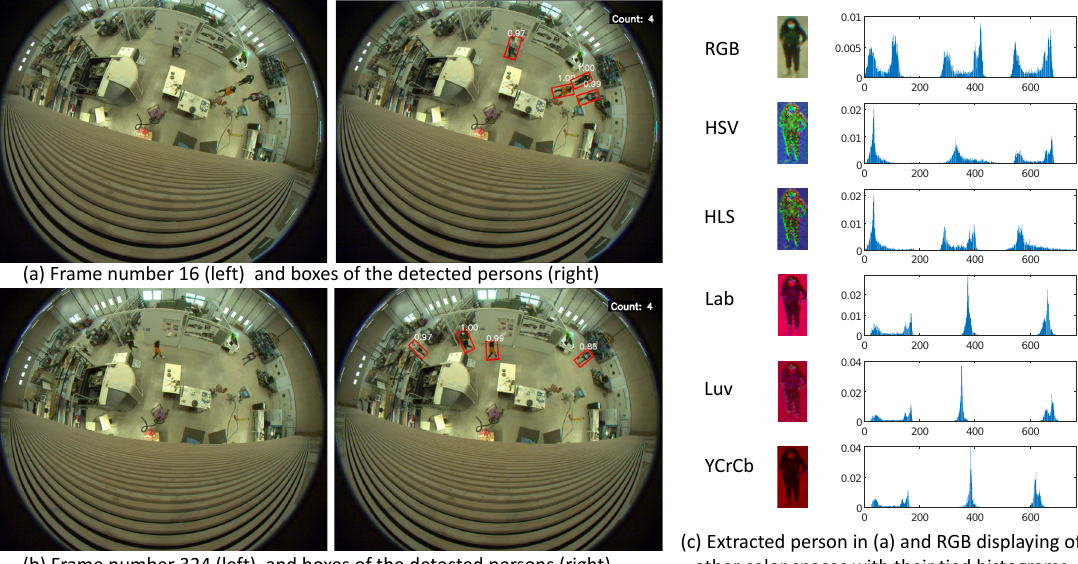
Figure 2. Persons extracted from fisheye images and displaying of different color space representation with their tied